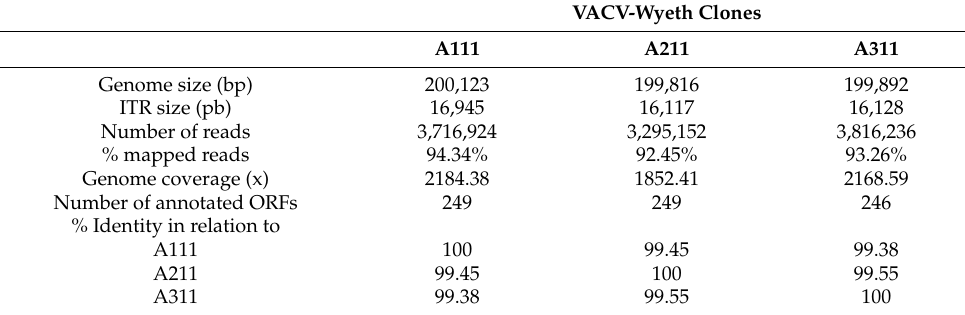
Table 1. Genomic features of the genomes of VACV-Wyeth clones A111, A211, and A311.